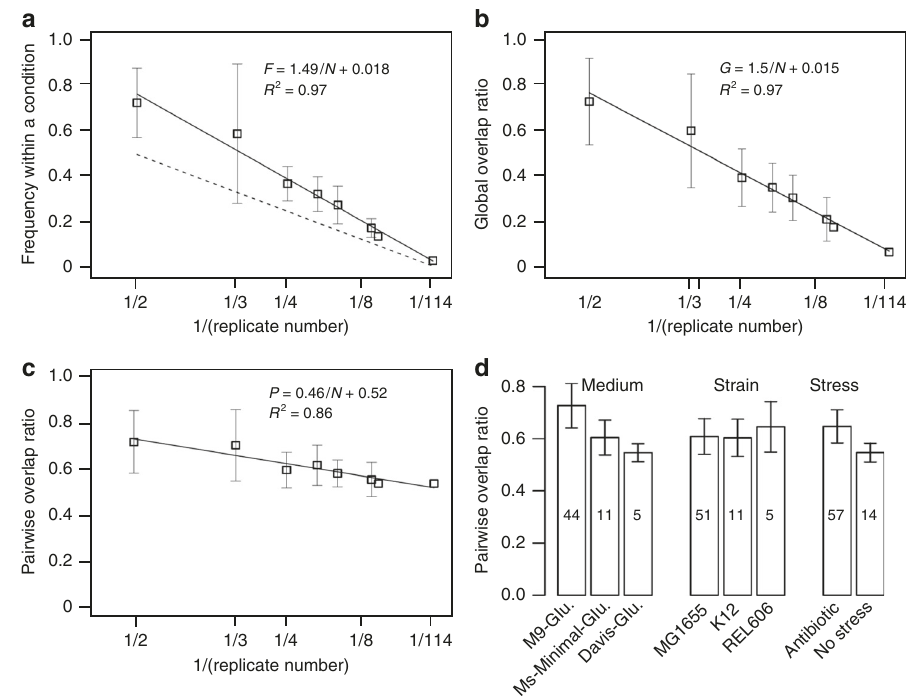
Fig. 4 Frequency and co-occurrence of mutations as a function of biological replicates. a The reciprocal of the number of biological replicates is linearly related to the number of the average frequency of a genome site mutated among all the replicates given in a culture condition. The culture conditions that have the same number of replicates were grouped as one data point in the plot (the dots without standard deviation bar corresponds to the case that only one condition has such number of replicates; this also applies to b and c ). The dash line describes a relation between number of replicates and frequency with a condition if each mutation occurred in only one replicate. b The average overlap between the mutated genome sites in a biological replicate and all the mutated genome sites under a culture condition as a function of the number of replicates. c The pairwise overlapping in mutated genome sites between biological replicates given a culture condition. d The pairwise overlapping ratio under different conditions was addressed against the medium, strain and stress, respectively. The number in each bar represents the number of culture conditions corresponding to that data point. The error bar represents the standard deviation of the pairwise overlapping ratio across the culture conditions corresponding to that data